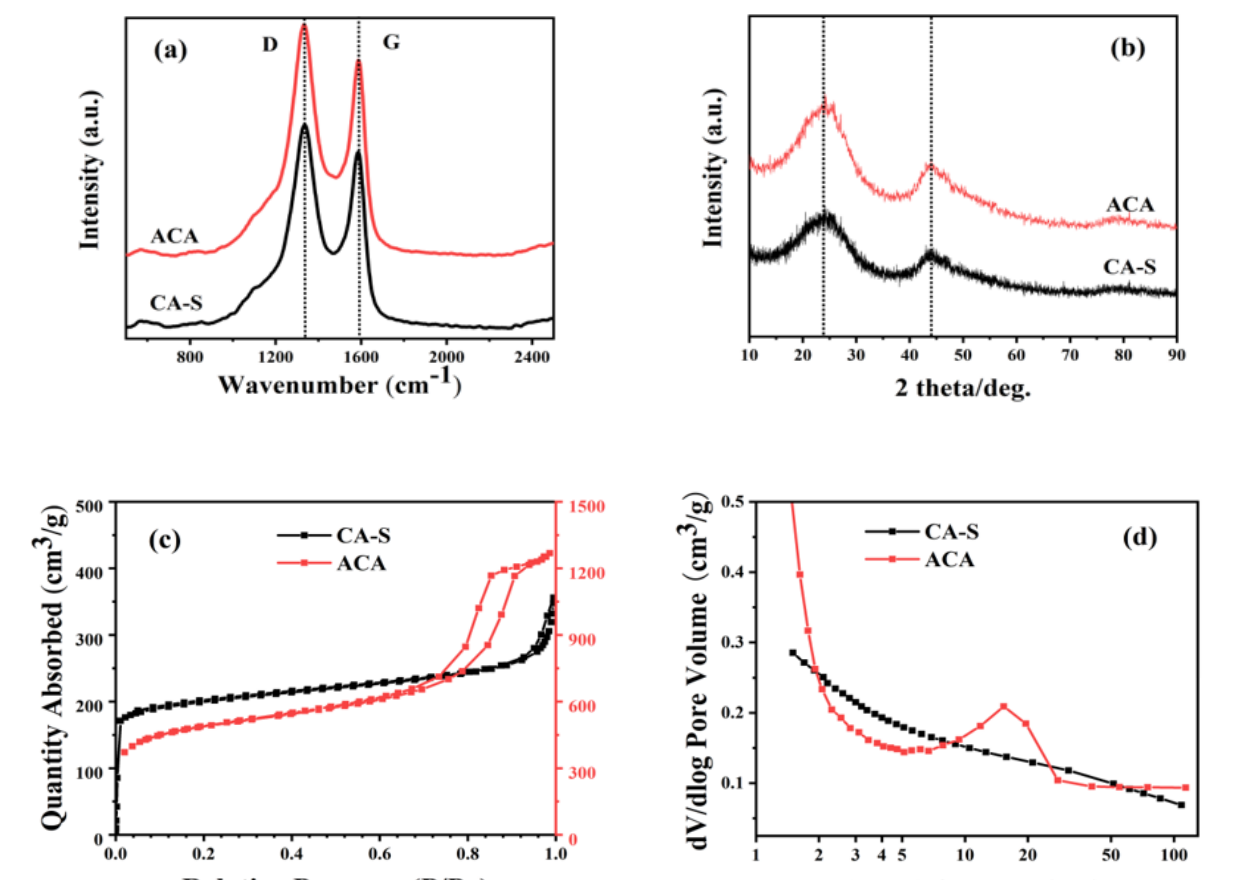
Figure 2. ( a ) Raman spectra of ACA and CA-S. ( b ) X-ray diffraction patterns of ACA and CA-S. ( c ) Isotherms of ACA and CA-S. ( d ) BJH pore distribution of ACA and CA-S.